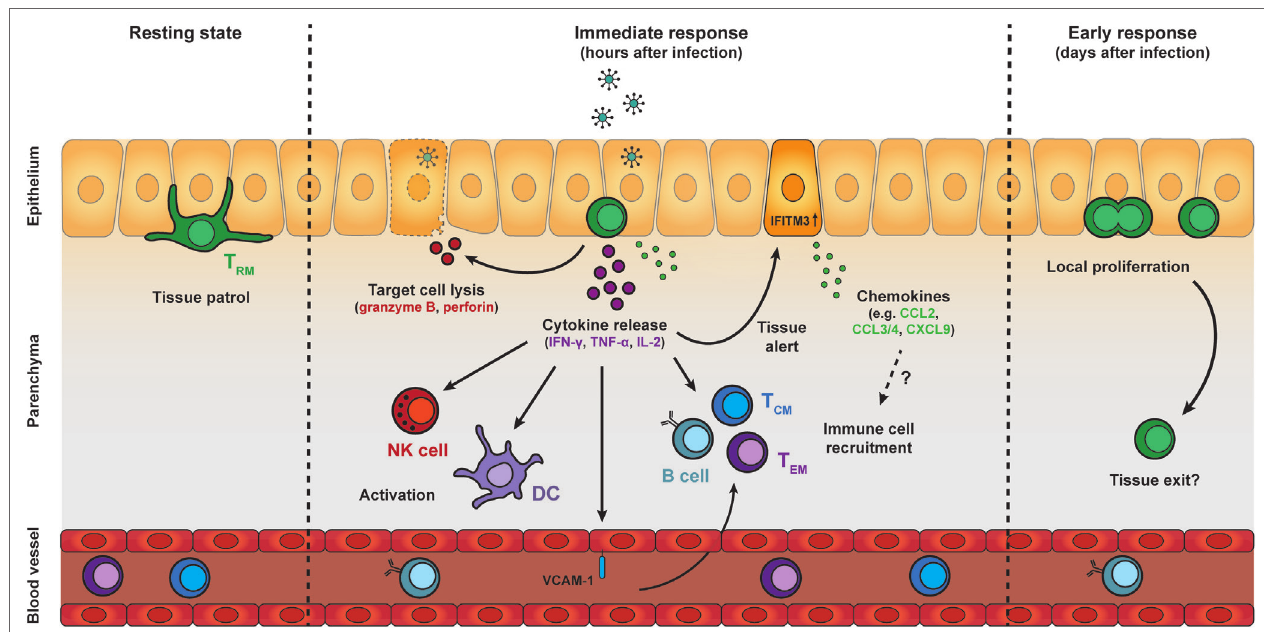
FigURe 2 | Protective effector responses of epithelial T RM cells upon secondary infection. T RM cells in the epithelia continually patrol their local environment, projecting dendritic extensions in multiple directions. Upon pathogen challenge and antigen re-encounter, T RM cells rapidly release pro-inflammatory cytokines, including IFN- γ , TNF- α , and IL-2, which induce several immune cell- and tissue-specific effects. Local cytokine release by T RM cells results in recruitment and activation of natural killer (NK) cells and dendritic cells (DCs), as well as upregulation of VCAM-1 on endothelial cells in local blood vessels, which may enhance the recruitment of T CM , T EM , and B cells from the circulation. T RM cell reactivation and cytokine release also induces a tissue-wide state of alert, resulting in upregulation of many innate immune response genes, including interferon-induced transmembrane protein 3 (IFITM3), and the increased local expression of inflammatory chemokines. The protective capacity of T RM cells may also rely on perforin-mediated killing of target cells. One to two days after antigen re- encounter, T RM cells undergo local proliferation. Further investigation is required to determine whether T RM cells exit their local environment after reactivation. Abbreviations: IFN- γ , interferon γ ; TNF- α , tumor necrosis factor α ; IL-2, interleukin 2; ICAM-1, vascular cell adhesion molecule 1; T CM cell, central memory T cell; T EM cell, effector memory T cell; CCL, C-C motif chemokine; CXCL9, C-X-C motif chemokine